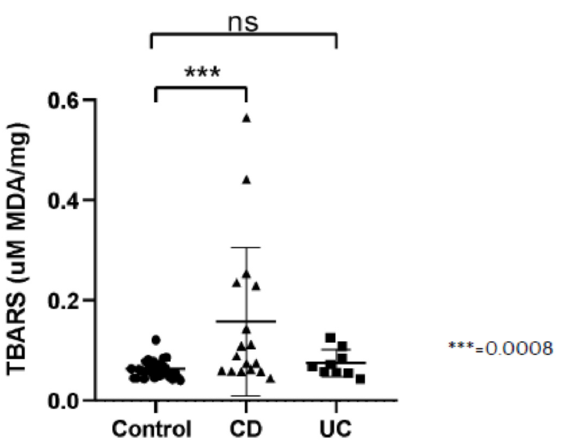
Figure 4. Thiobarbituric Acid Reactive Substances (TBARS) presented as concentration of malondialdehyde (MDA) per milligram tissue sample (uM MDA/mg sample) in healthy subjects (Control), in patients with Crohn’s disease (CD) and ulcerative colitis (UC).